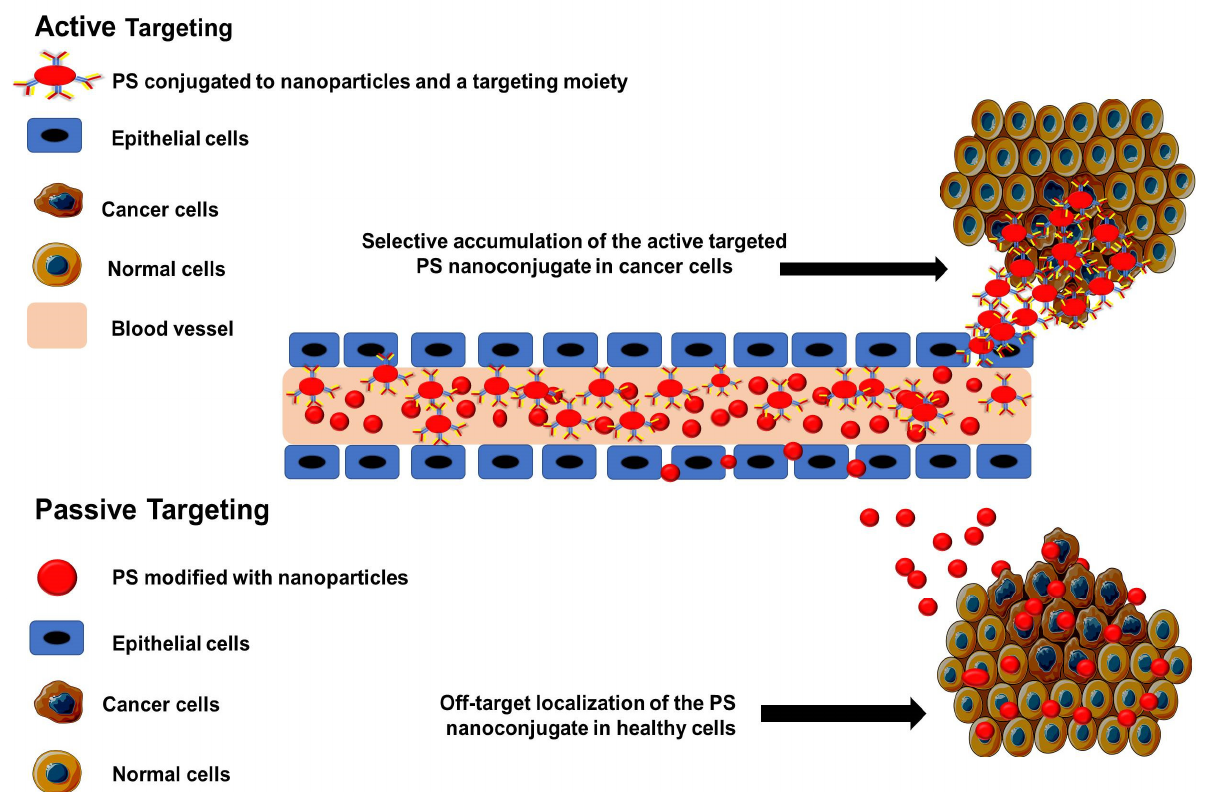
Figure 3. Passive and active nano-PS tumor targeting and delivery systems used for the PDT treat- ment of cancer. treatment of